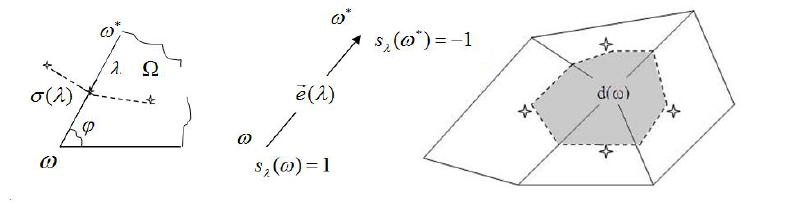
Figure 1. A basis building using the SOM algorithms. Solid lines determine cells created in modeling area and responsible for different sediment matter. Dashed lines serve to create a border at a homogeneous matter and to calculate the flow over the